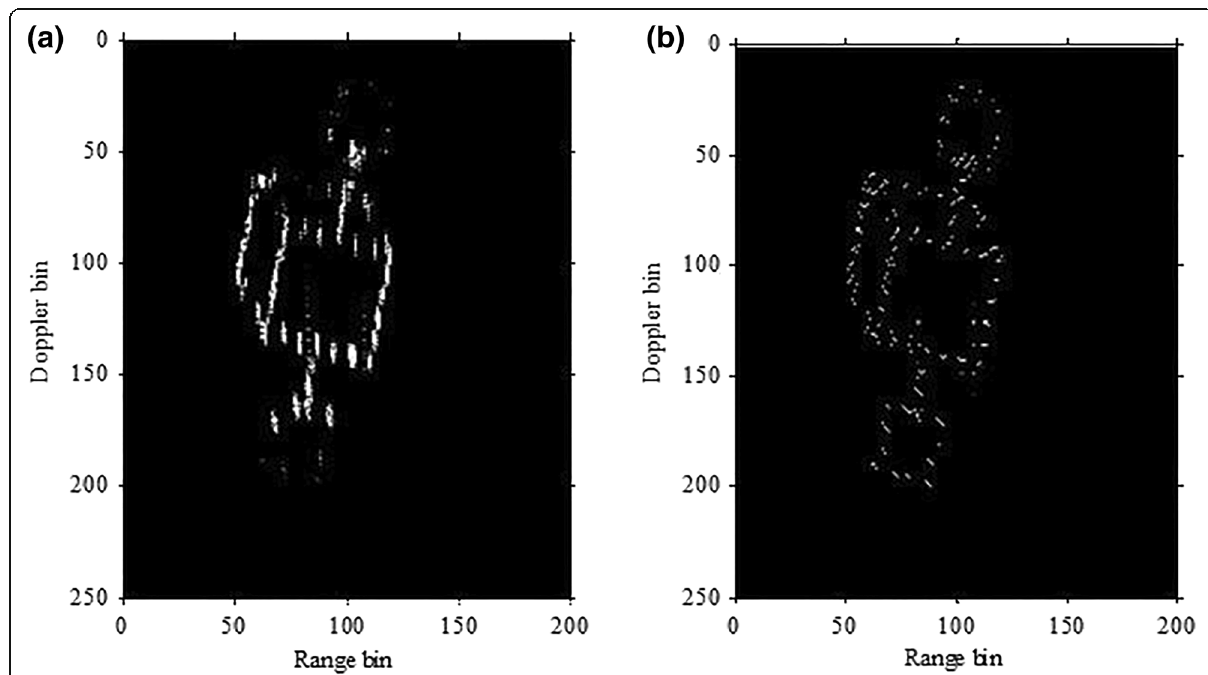
Fig. 7 Simulation results of the proposed algorithm. a Result of m-D removal algorithm in Section 4.1. b Result of the proposed